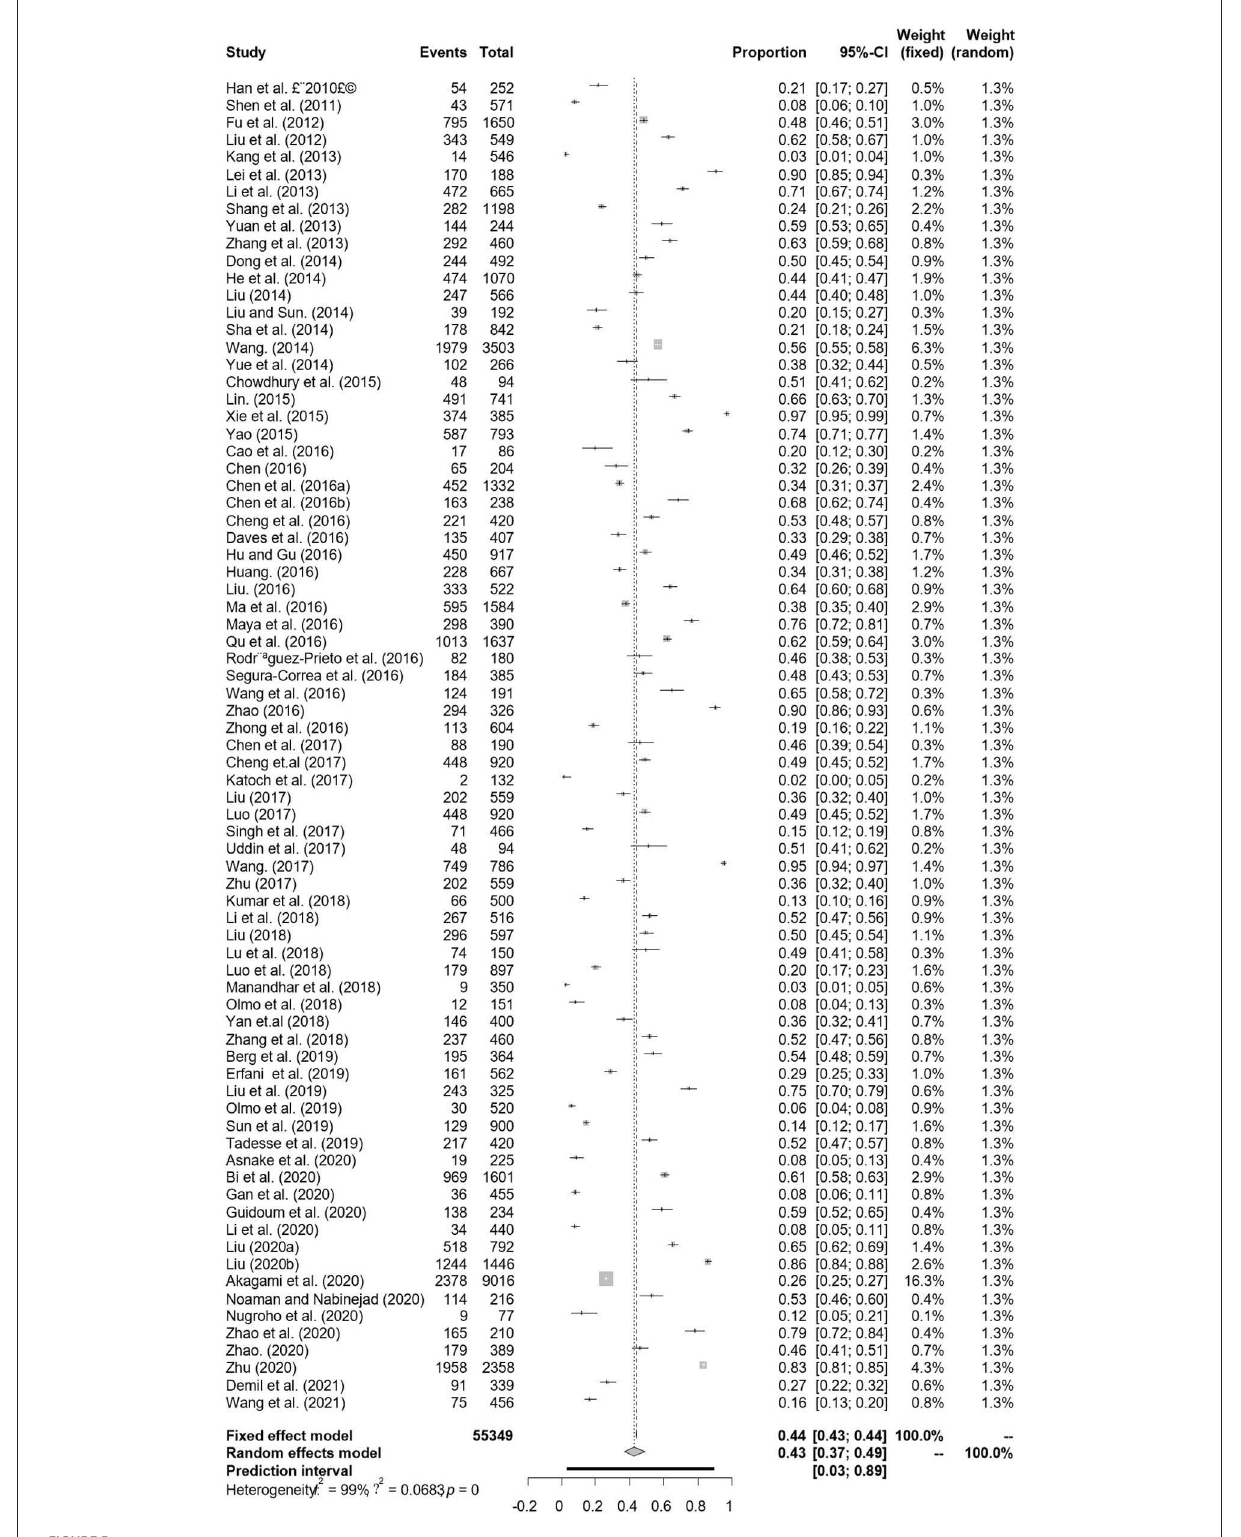
FIGURE5 Forest plot of bovine viral diarrhea virus antibody prevalence in the world study conducted 2010–2021 (decetion